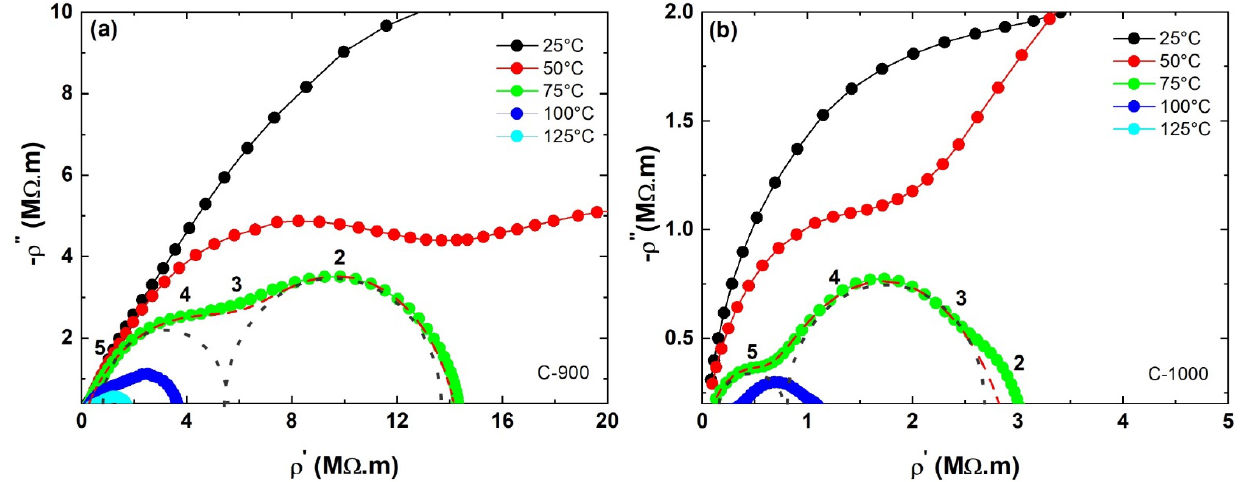
Figure 8. Argand diagram of iron antimonate ceramic pellets: ( a ) C-900; ( b ) C-1000. Numbers over the semicircles represent the power of the frequency. The dashed red line represents the adjustment performed on the semicircles of the grain region and grain boundary of the FeSbO 4 and black dashed represents the deconvoluted grain and grain boundary regions.